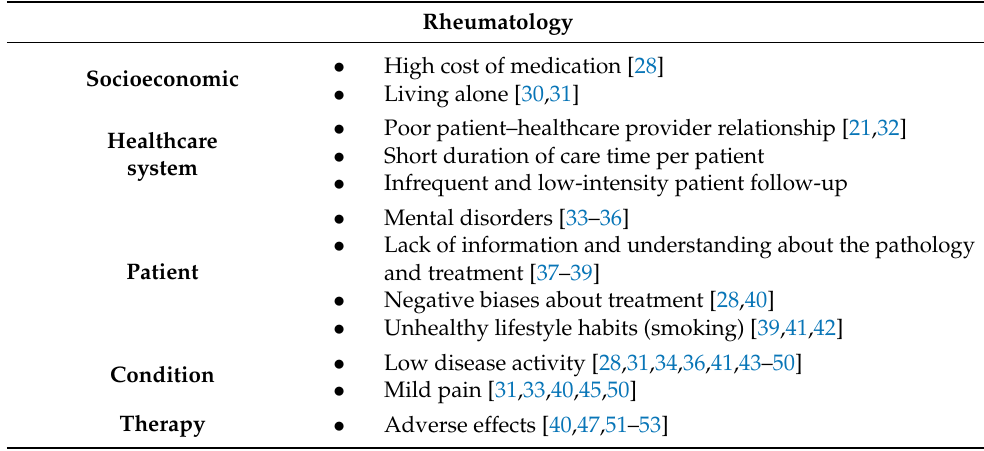
Table 1. Rheumatology risk factors of